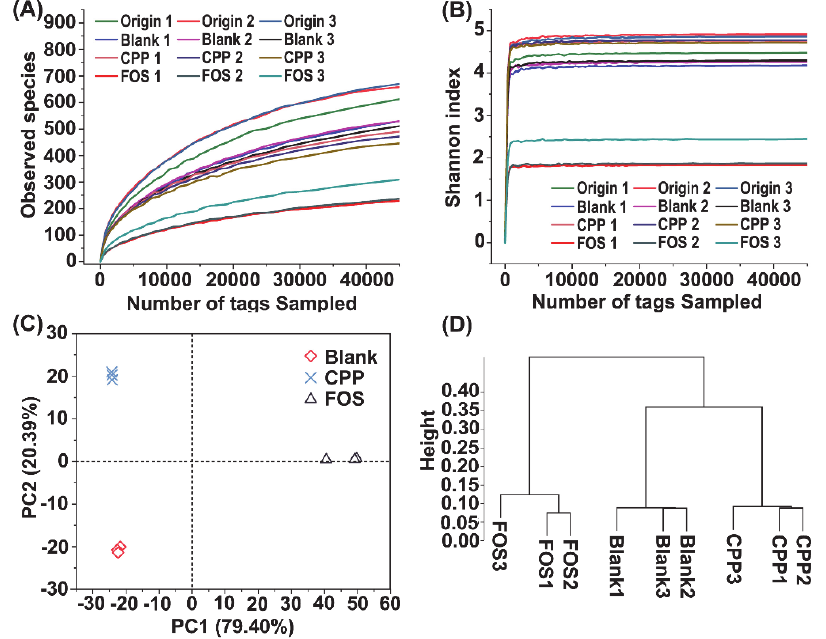
Figure 3. Observed species ( A ) and Shannon index ( B ) of fecal samples from the origin, blank, CPP, and FOS groups. The bacterial compositions among groups by PCA ( C ) and cluster analysis ( D ) at OTU level. Table 2. Alpha-diversity for origin, blank, CPP, and FOS groups.